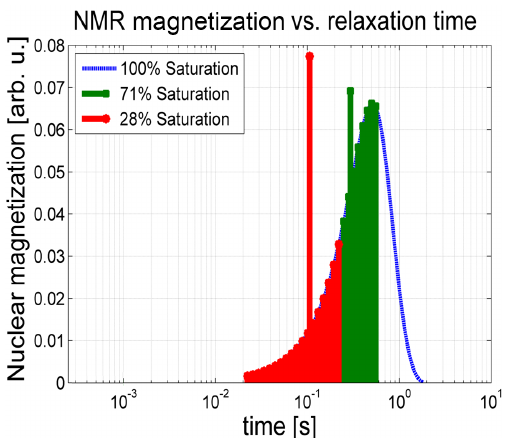
Figure 13. Relaxation components of fully (blue line) and partially desaturated triangular pore size distribution. At a specific satura- tion level, all pore corners with residual saturation exhibit the same NMR magnetization and relaxation behavior, thus superposing to a single fast relaxation component (e.g., red and green bars).